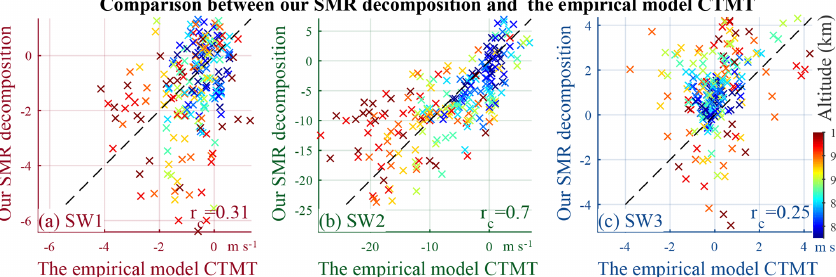
Figure 8. Scatterplots of SW1, SW2, and SW3 shown in Fig. 4a–f against those shown in Fig. 4g–l. Each cross in panels (a) , (b) , and (c) represents the real or imaginary part of 1 pixel in Fig. 7g, h, and